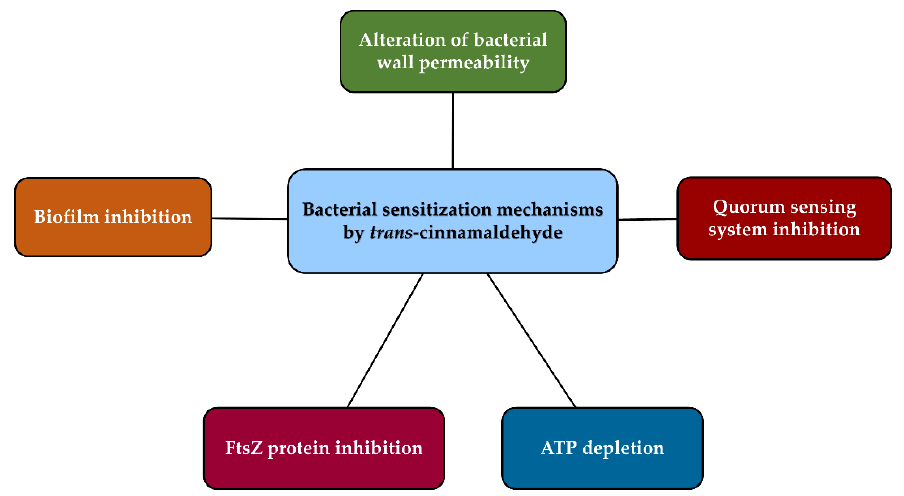
Figure 4. Possible mechanisms underlying the bacterial sensitizing properties of trans -cinnamalde-